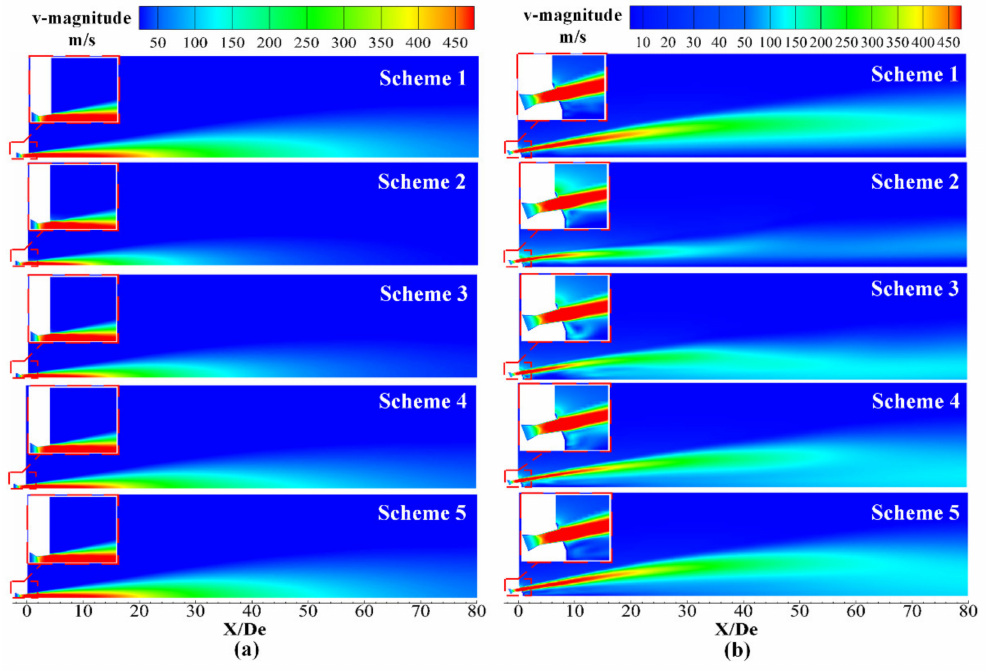
Figure 7. Velocity distribution of the supersonic jet along the longitudinal section. ( a ) Laval nozzle and ( b ) lance